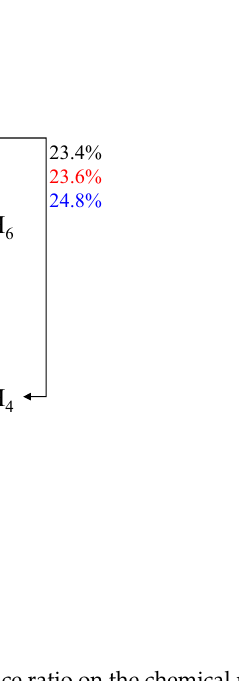
CH 2 O Figure 10. Effects of initial pressure on the chemical reaction path of kerosene (T = 800 K; Φ = 1; black: P = 15 bar; red: P = 20 bar; blue: P = 25 bar) .